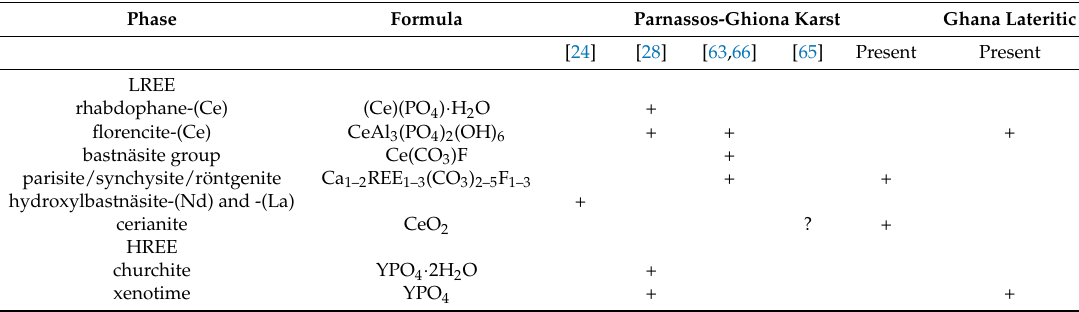
Table 4. Precursor REE phases in the bauxite feed of AoG